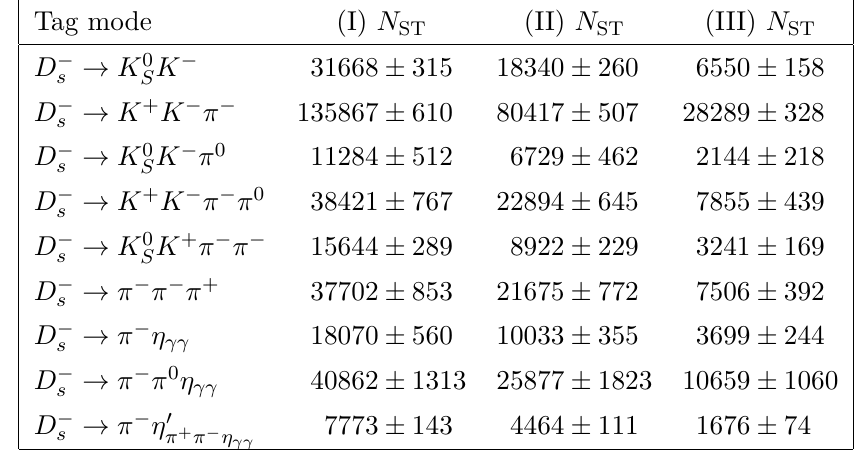
√ s = (I) 4.178 GeV, (II) 4.199–4.219 GeV, and